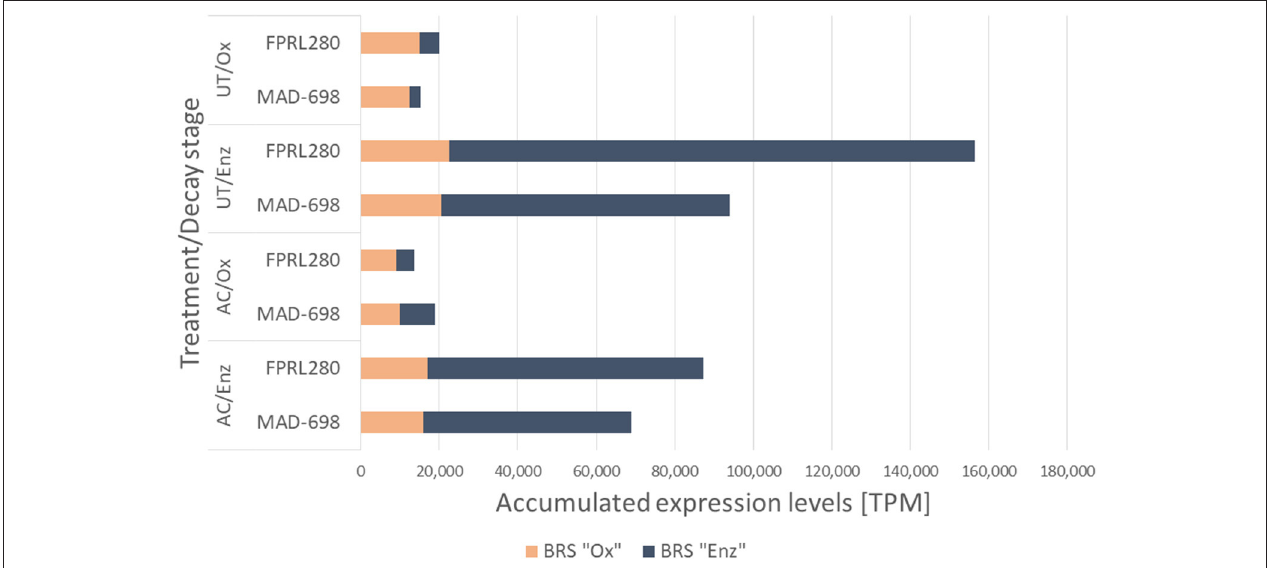
FIGURE 7 | Accumulated expression values for the brown rot specific genes of the two R. placenta strains FPRL280 and MAD-698 for all four treatments.